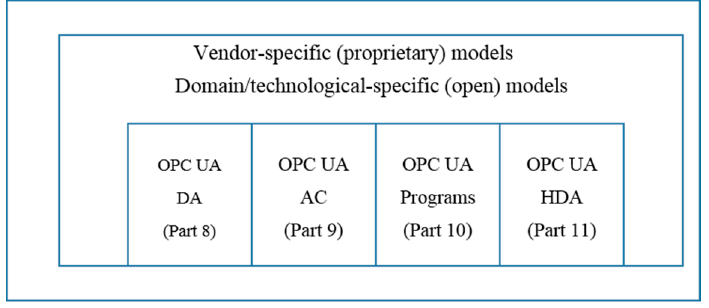
Figure 1. Information model of integrated OLE (object linking and embedding) for process control OPC unified architecture (UA).